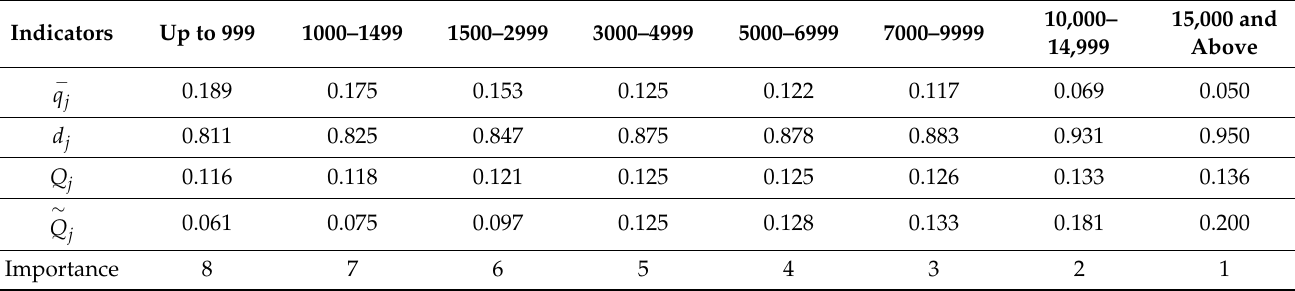
Table 6. Distribution of factors according to importance.